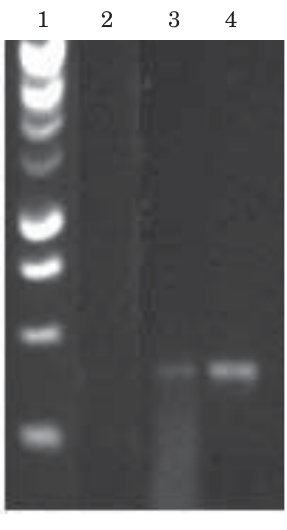
Fig. 2. Agarose gel electrophoretic analysis of the coat protein gene of grapevine virus A amplified by RT-PCR using the primer pair H587/C995. Aliquots (5 µl) of the PCR products were analyzed in a 1% agarose gel. Lane 1, 1-Kb DNA size marker; lane 2, negative control; lanes 3 and 4, symptomatic field